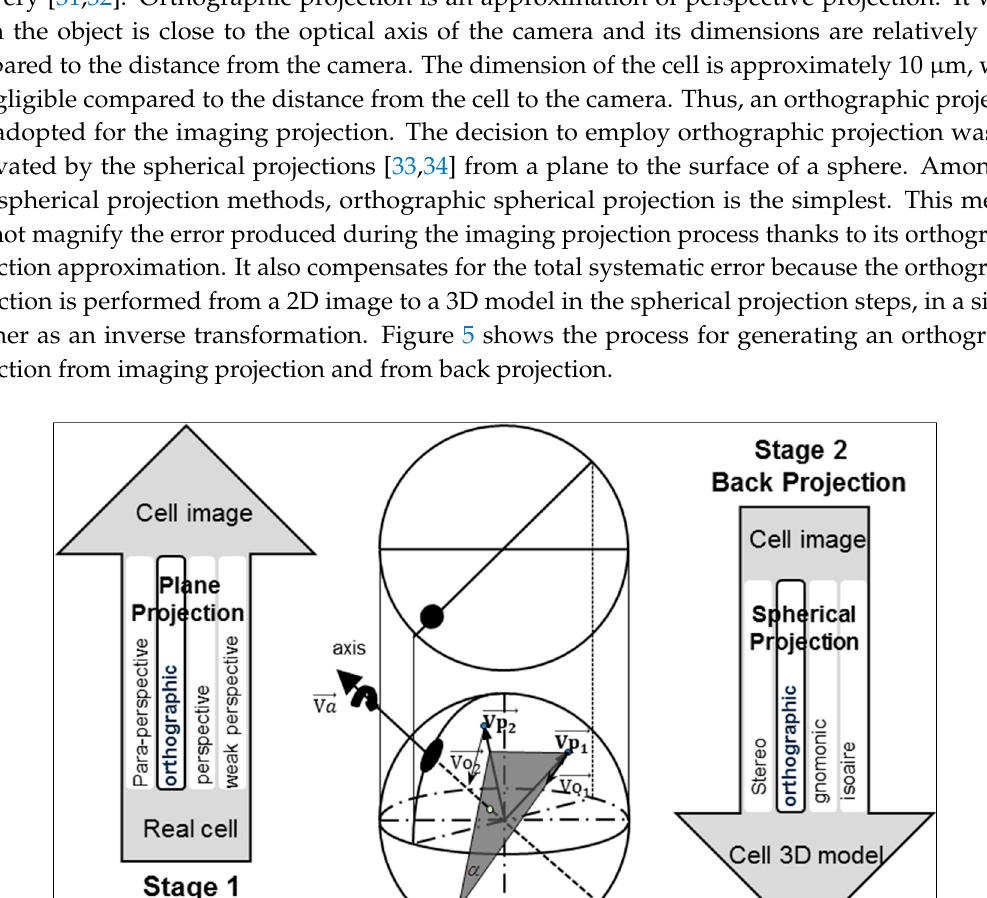
 → → V and V p 1 and V p 2 1 p  → → V V o 1 and V o 2 are 1 o → V α